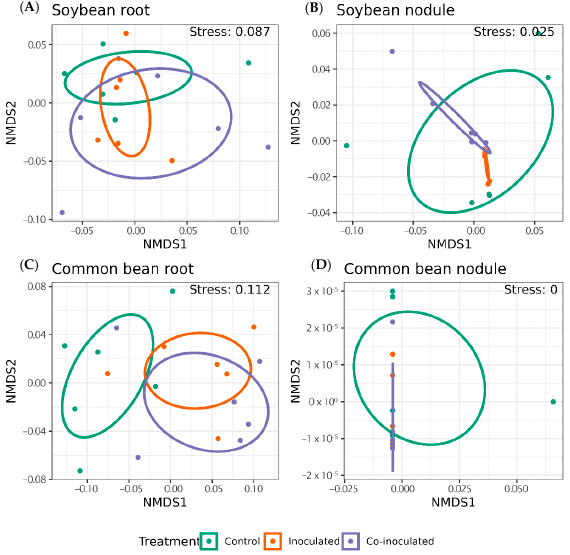
Figure 8. Bacterial weighted UniFrac beta diversity distances in the microbiomes of roots and nodules of common bean and soybean non-inoculated (control). Inoculated with specific rhizobia, and co-inoculated with rhizobia and Azospirillum brasilense.